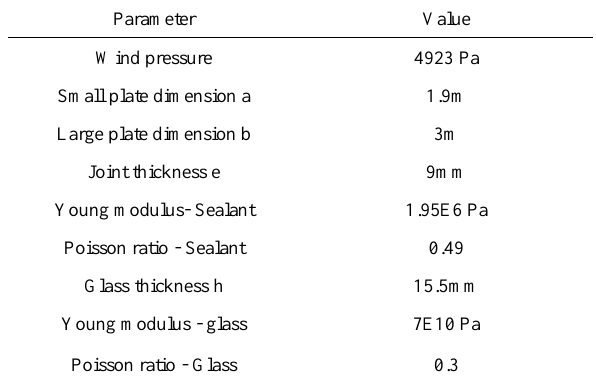
Table 4: Parameters used for the calculation of the plate deflection as a function of the sealant